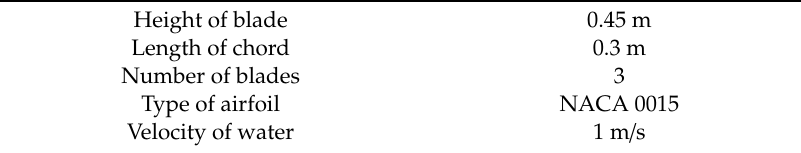
Table 1. Turbine geometrical and stream